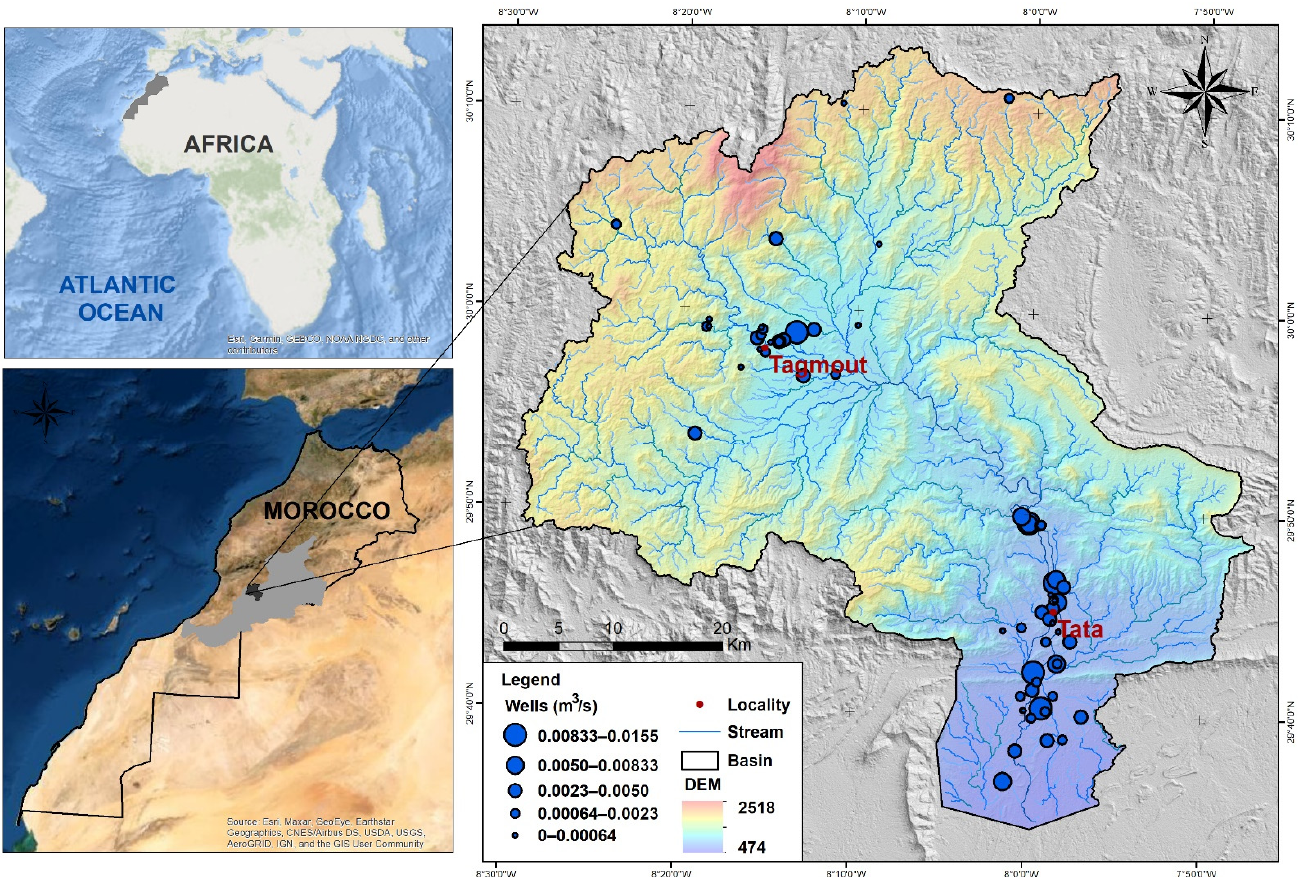
Figure 1. Location of the Tata basin with digital elevation model (DEM).